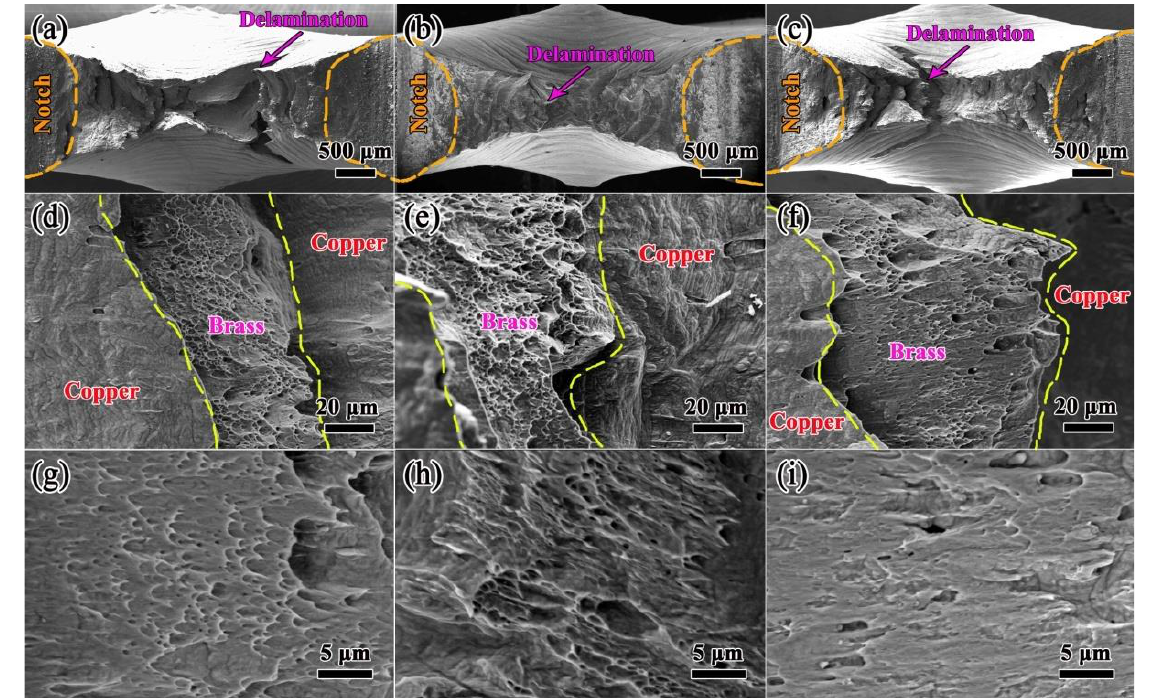
Figure 8. ( a – c ) The fracture surfaces of the copper – brass blocks impacted at LNT, RT, and 200 °C, respectively. ( d – f ) The fracture morphologies of the copper and brass layers at LNT, RT, and 200 °C, respectively. ( g – i ) The morphologies of the delaminated copper – brass interfaces at LNT, RT, and 200 °C, respectively.